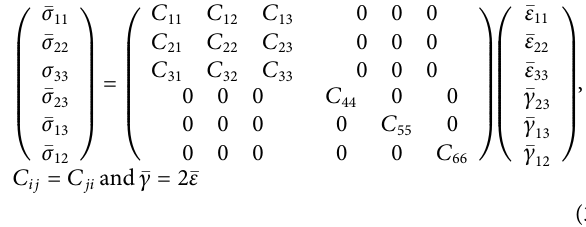
Frontiers in Mechanical Engineering |